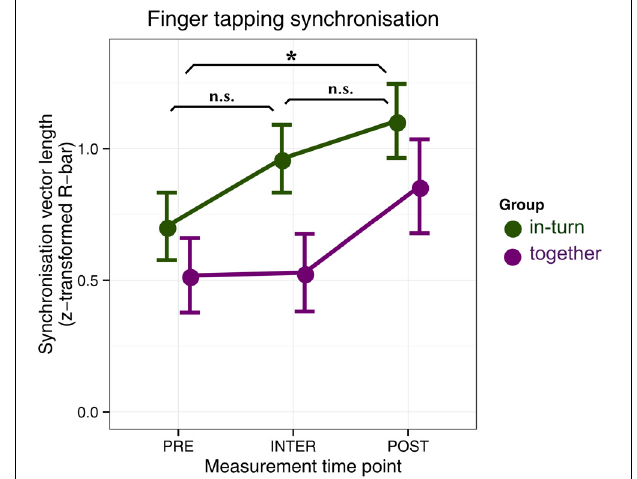
FIGURE 3 | Synchronization tapping performance before therapy (PRE), in between the individual and joint sessions (INTER), and after therapy (POST). Error bars indicate standard error of the mean. Significance of the main effect (across groups) is indicated: ∗ p < 0 . 05.